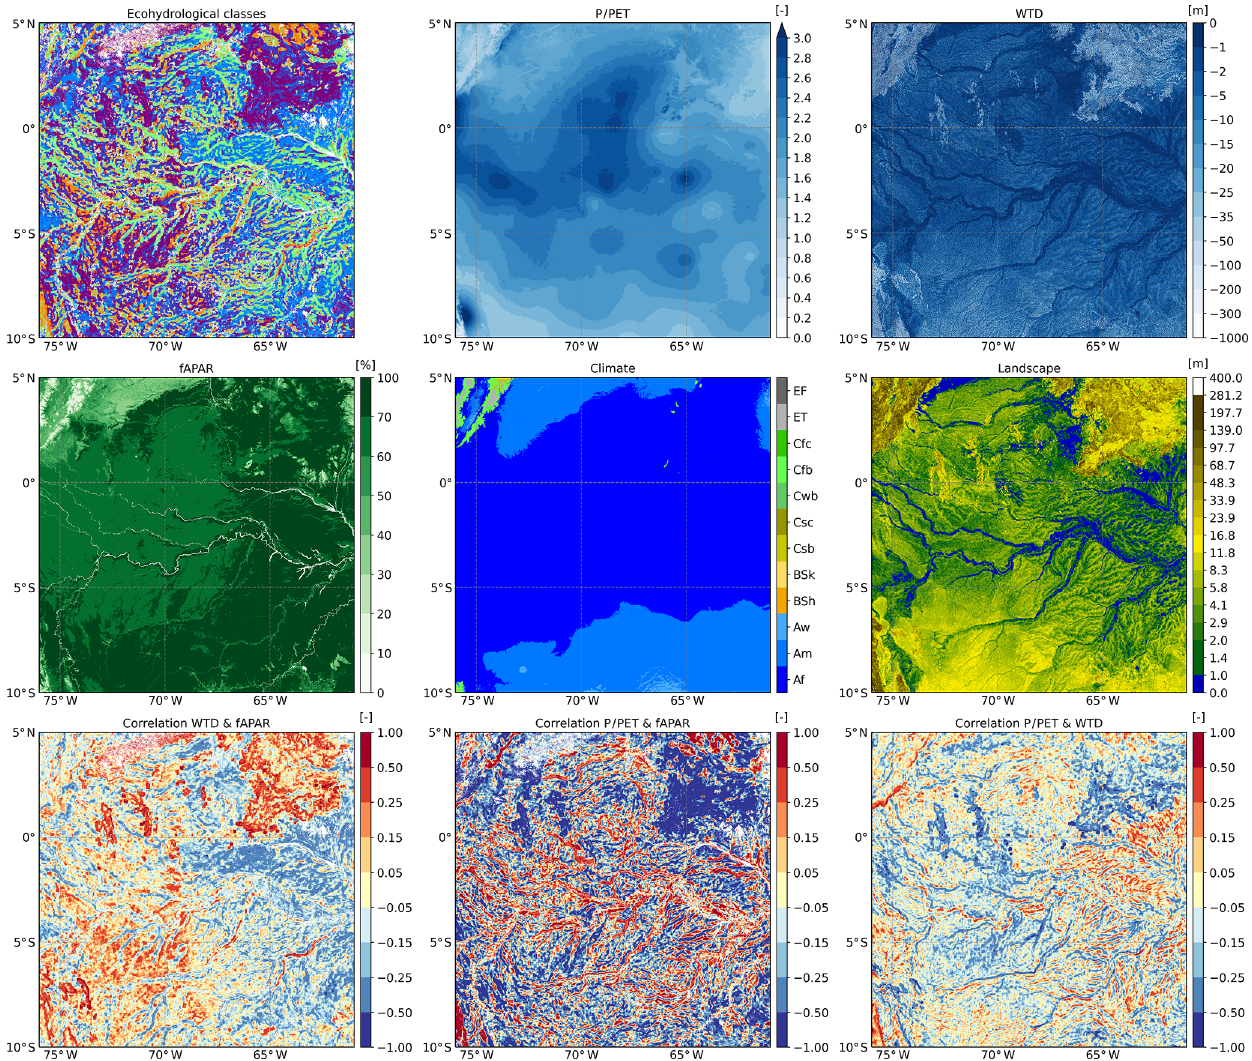
Figure 4. High-resolution illustration of ecohydrological classification in the Amazon. Input and correlation maps are shown at the full resolution of 30arcsec. The white pixels in the upper left map (ecohydrological classes) represent the locations where the correlations were not calculated due to the tree height falling below the threshold value of